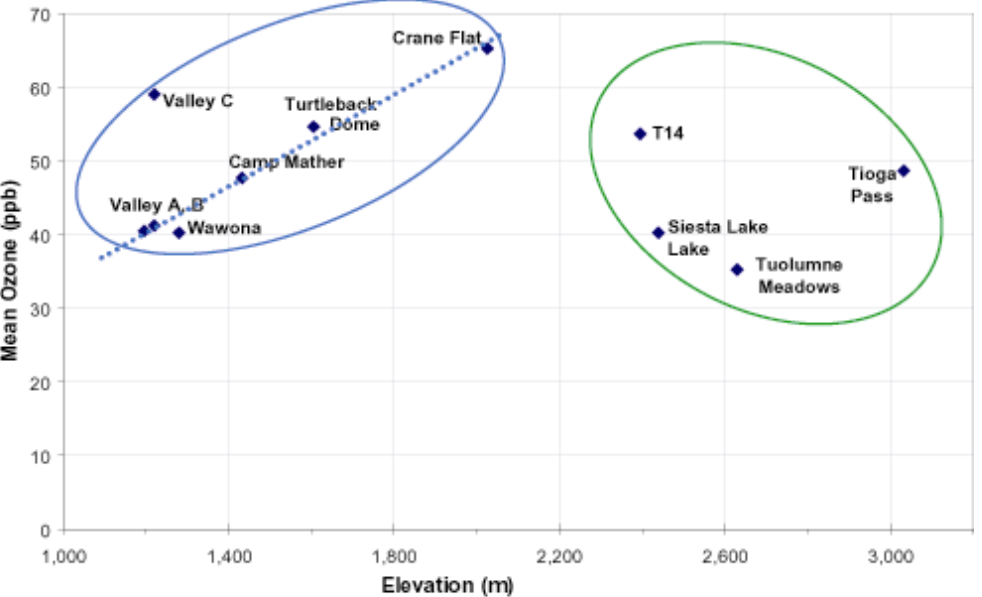
FIGURE 10. Mean seasonal ozone concentrations plotted against elevation for each of the passive ozone measurement sites in Yosemite NP. Factor analysis of the weekly data separates the sites into two groups. The west-side sites increase in ozone concentration with elevation up to about 2000